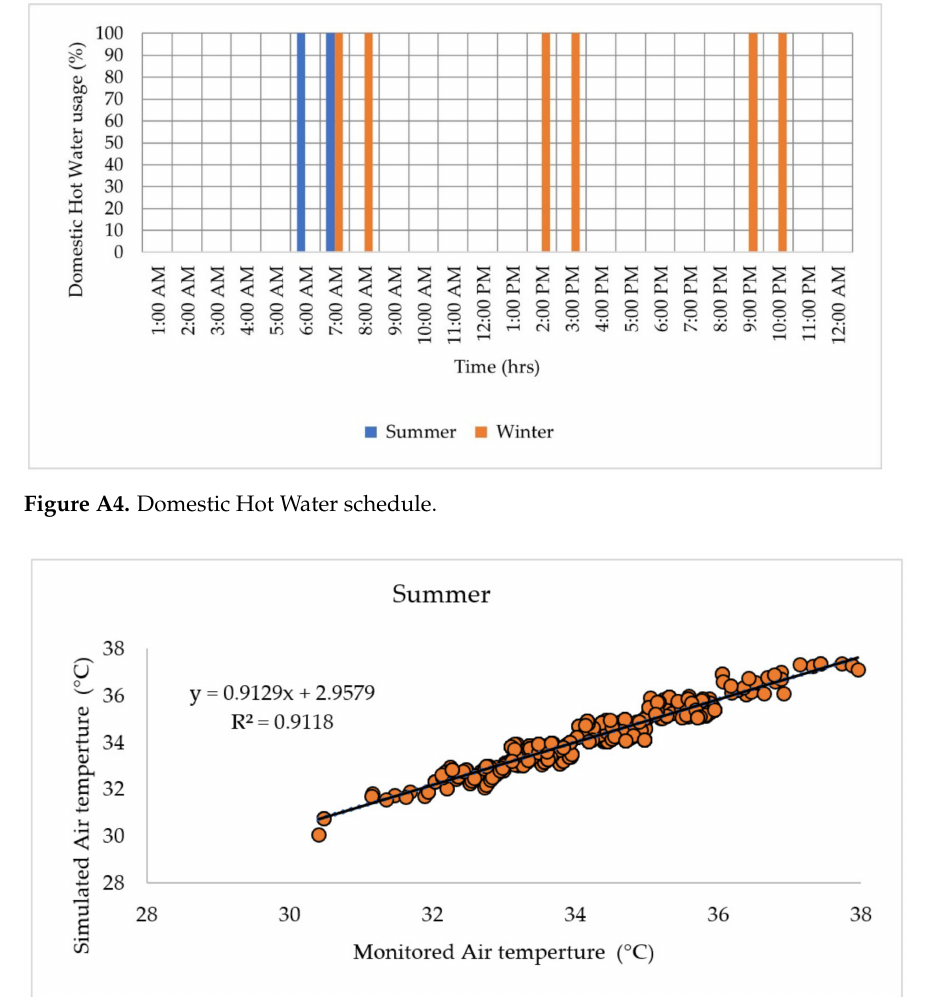
Figure A5. Linear regression analysis of calibration of the simulation model for